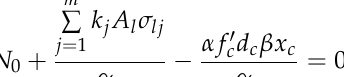
Figure 6. Vertical strain and stress profiles of RC column: ( a ) strain profile; ( b ) stress profile. The stress profile of the concrete is quantified using the equivalent rectangular stress block. The compressive depth is then determined by the axial equilibrium: